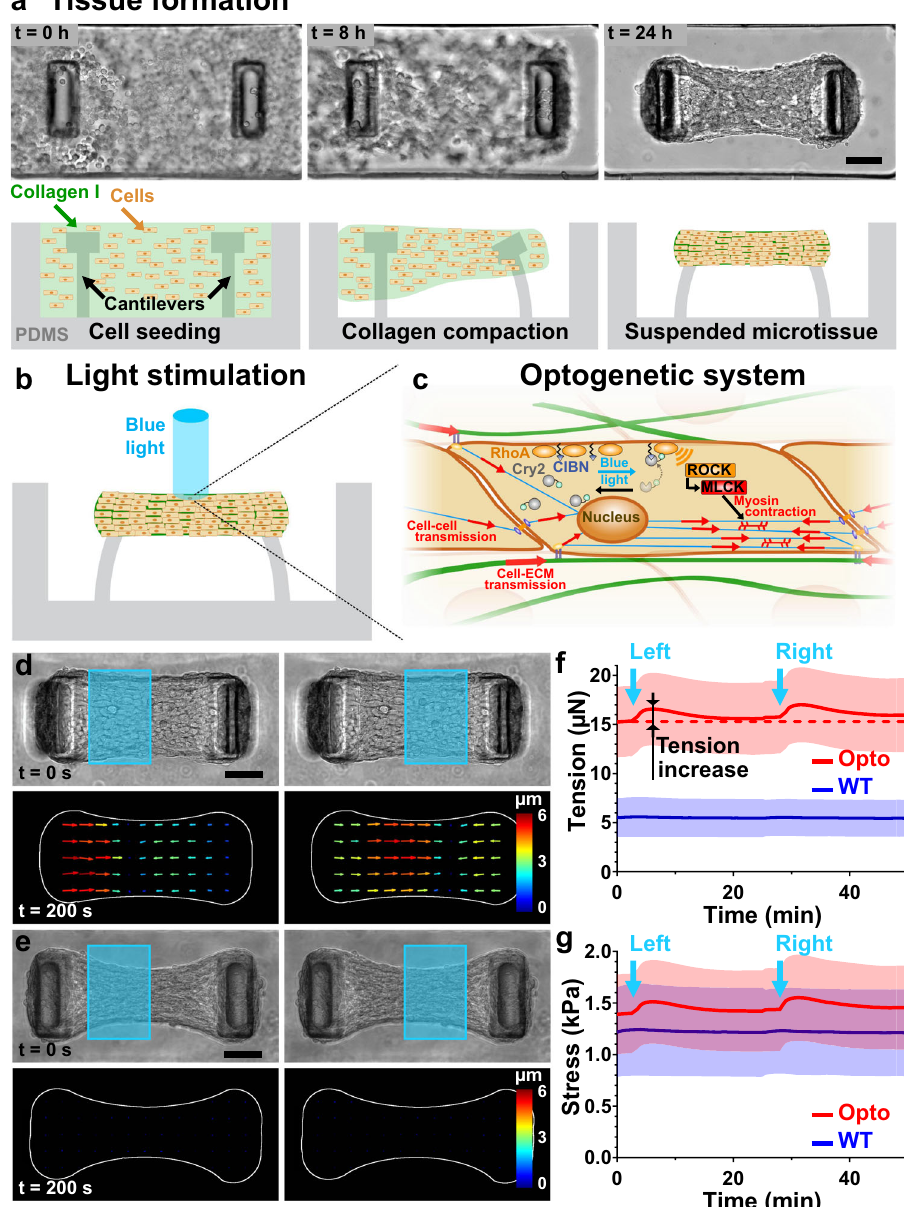
Fig. 1 | Light-controlled contraction of microtissues. a Representative top view images, among 21 microtissues over 3 independent experiments, and side view schemesdepictingtheformationofamicrotissue.Overthe fi rst24hofcultivation, the fi broblasts spread and spontaneously compact the collagen matrix. The two T-shapedcantileversanchorandconstrainthecontractionofthecollagenmatrixto formamicrotissuethatspansacrossthe top of thepairofcantilevers. b Schematic illustrating the light-stimulation of a microtissue composed of Opto-RhoA fi bro- blasts. c SchematicoftheARHGEF11(DHPH)-CRY2/CIBN-CAAXoptogeneticsystem to control cellular contractility. Upon blue light stimulation, CRY2 changes